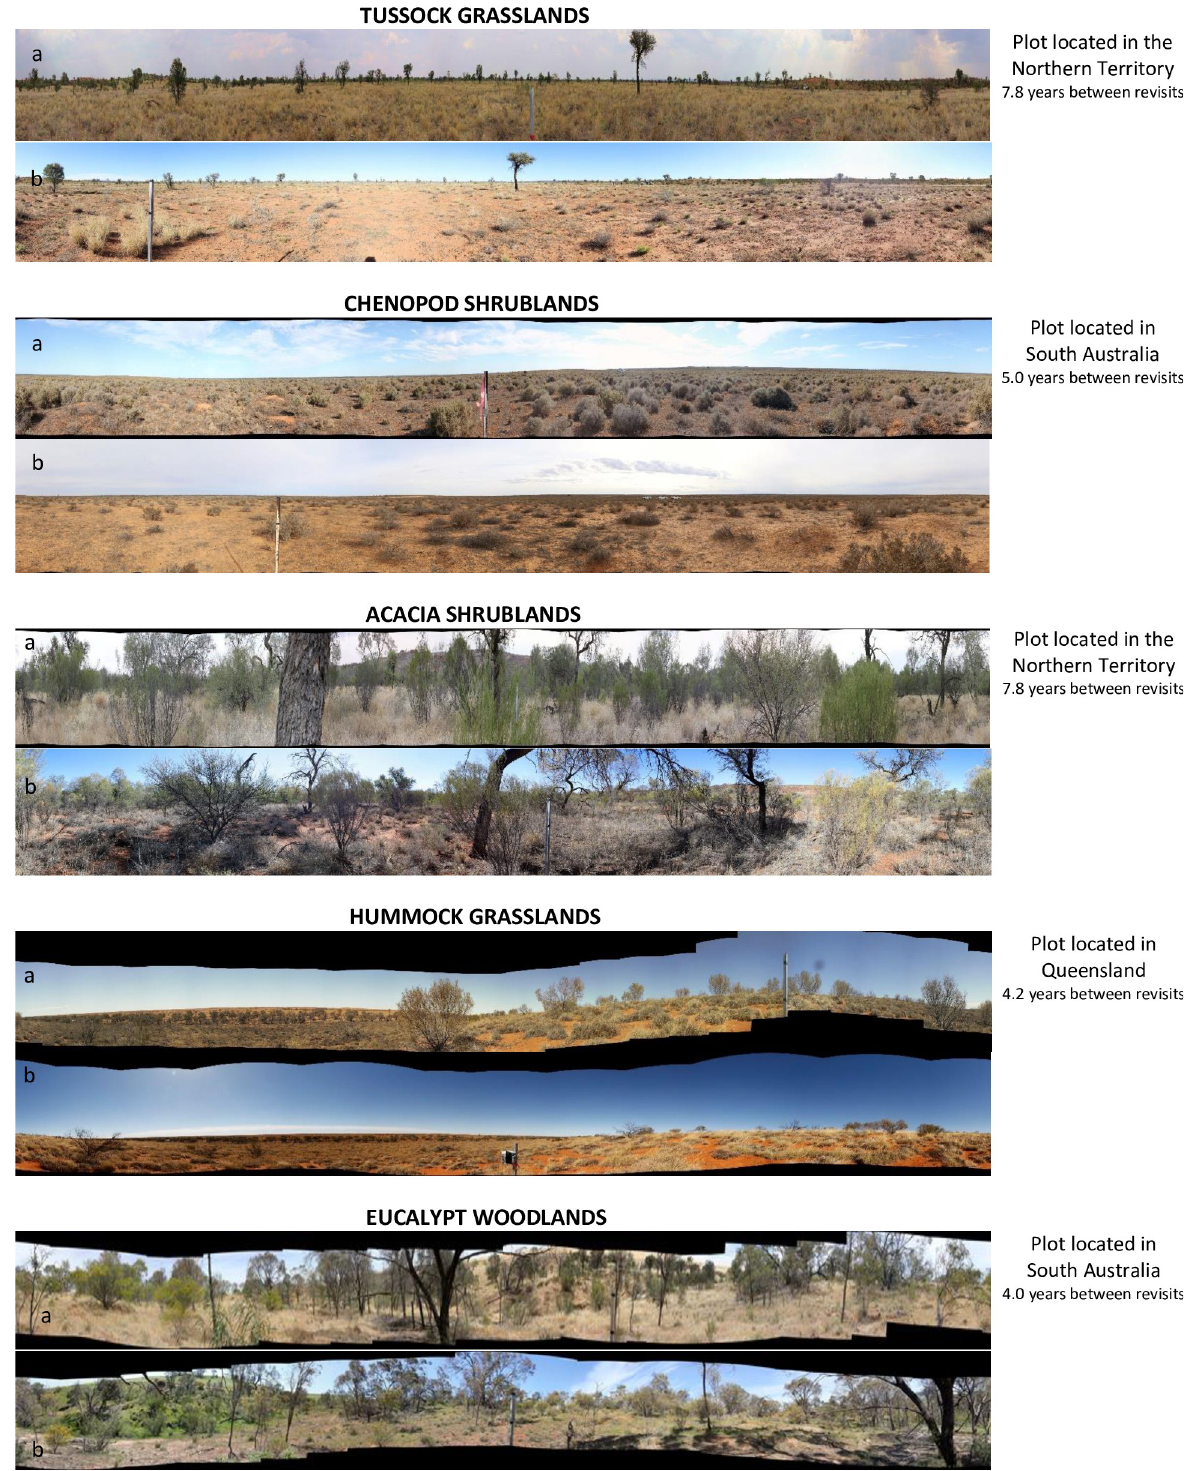
Fig 2. Panoramic view of plots. Panoramic view of plots. with the largest shifts in vegetation between the first (a) and last (b) visits and the interval between surveys. The panoramic photos could not be lined up precisely, but angle and depth of field were as similar as possible. Photo Credit: TERN Ecosystem Surveillance